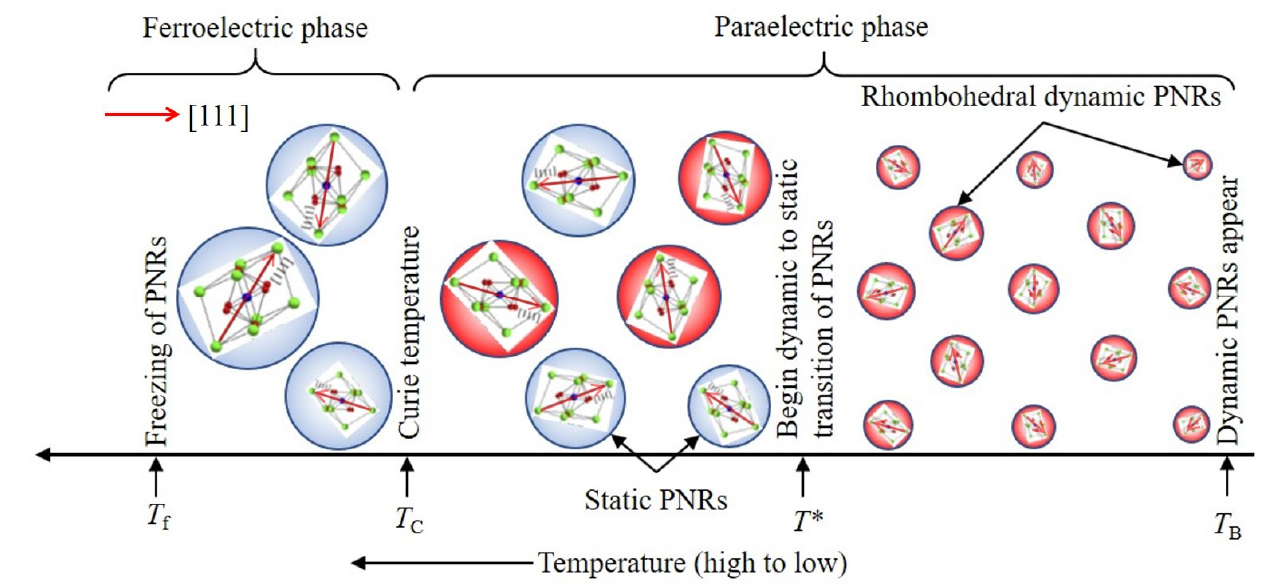
Figure 2. A schematic illustration of the temperature evolution of PNRs in relaxor-like KTN crystals based on the inelastic light scattering results. Red denotes the dynamic PNRs and blue indicates static PNRs, where the arrow denotes the orientation of PNRs. The dynamic PNRs appear at the so-called Burns temperature, T B . Upon cooling, the size of the dynamic PNRs increases slowly and dynamic PNRs become more sluggish due to the cooperative interaction with the neighboring PNRs. Eventually, the dynamic PNRs start to become static PNRs at the intermediate temperature, T *. For further cooling, the size of PNRs becomes intense due to their growth in addition to the merger of neighboring PNRs.